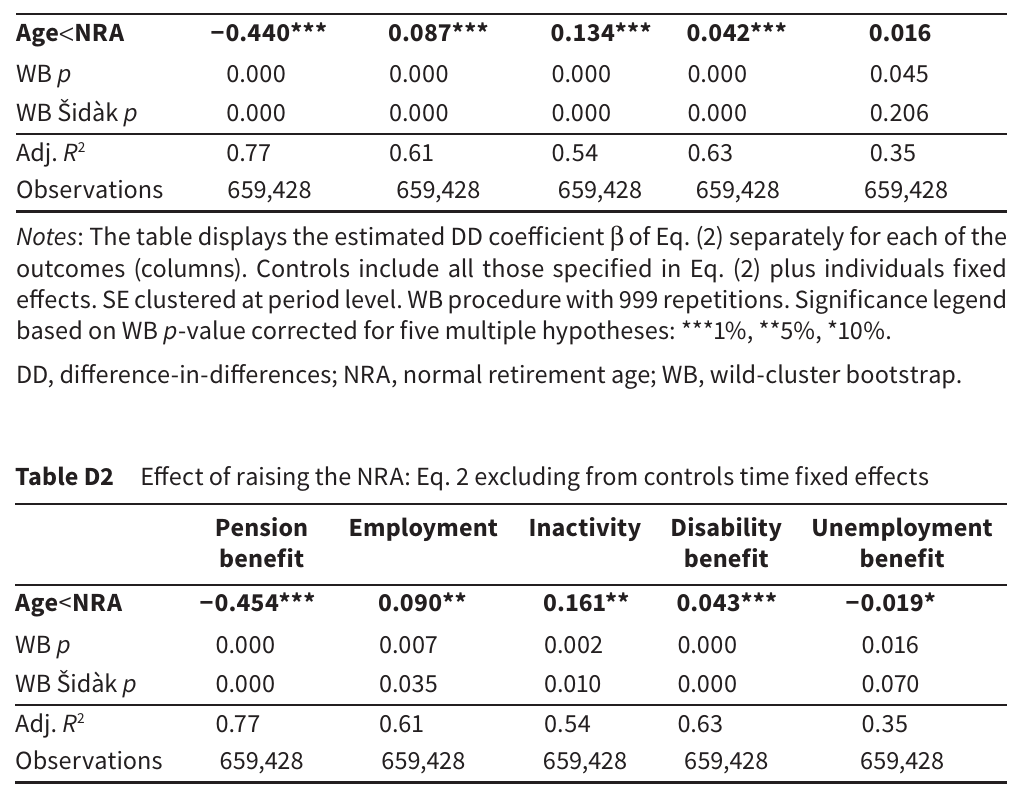
Effect of raising the NRA: Eq. 2 controlling also for Individual Fixed Effects Pension Employment benefit